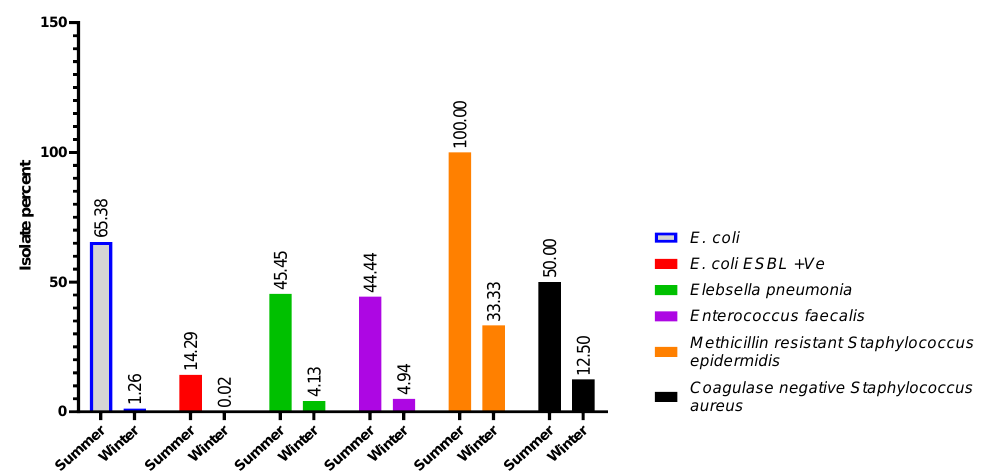
Figure 2. Percentage of uropathogens during summer and winter. Note : The 118 uropathogenic isolates were identified between May 2017 and April 2018; the summer season was categorized from March to August and September to February, which was considered winter season.